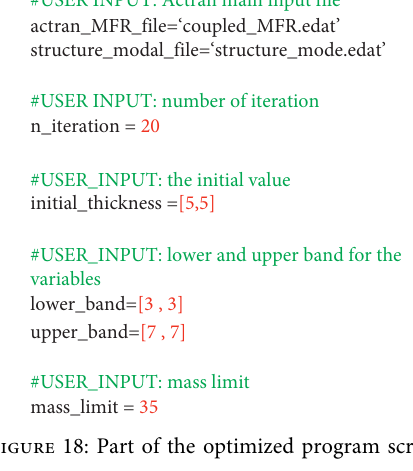
Figure 18: Part of the optimized program script.